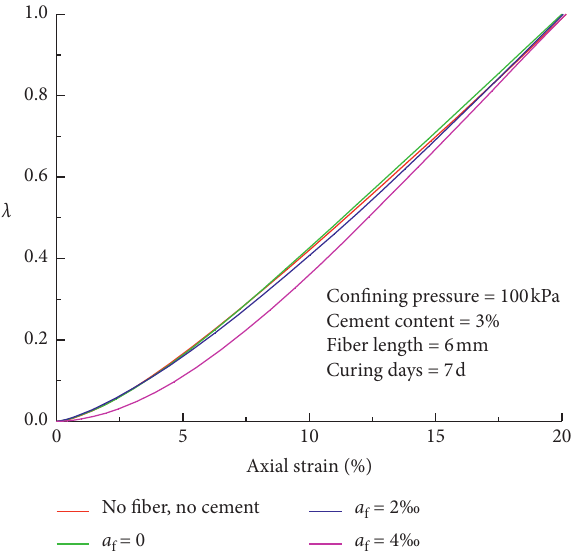
Figure 18: Variation in the normalized absorbed energy with axial strain for different fiber